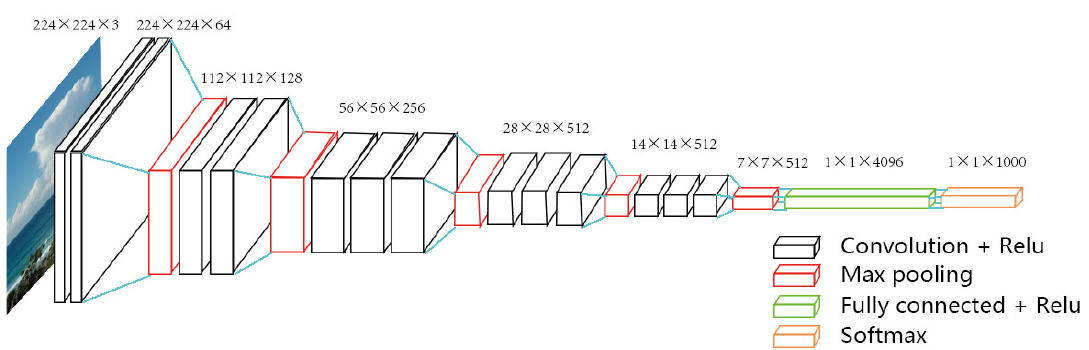
Figure 8. VGG16 structure. The network contains 16 convolutional layers, 5 pooling layers, and 1 fully connected layer.